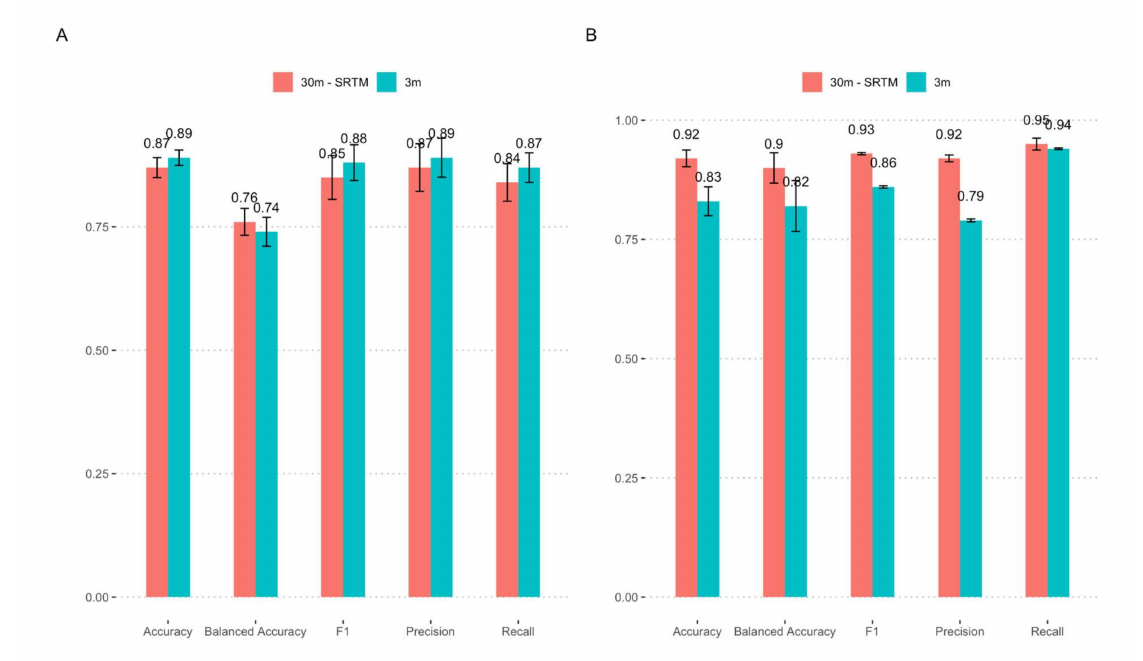
Figure 10. Model performance of DEM with derived attributes (DEM, slope, aspect and northness) model when 3 m was evaluated against a 30 m DEM (via SRTM). ( A ) Performance metrics over the Gunnison site. ( B ) Performance metrics over Engadin site. Bars show standard